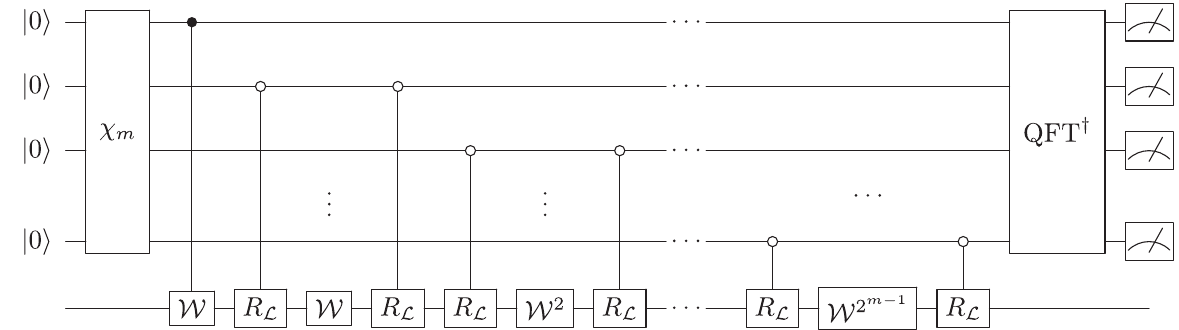
˜ O ð m Þ , which is completely negligible · SELECT gates are L and as many L